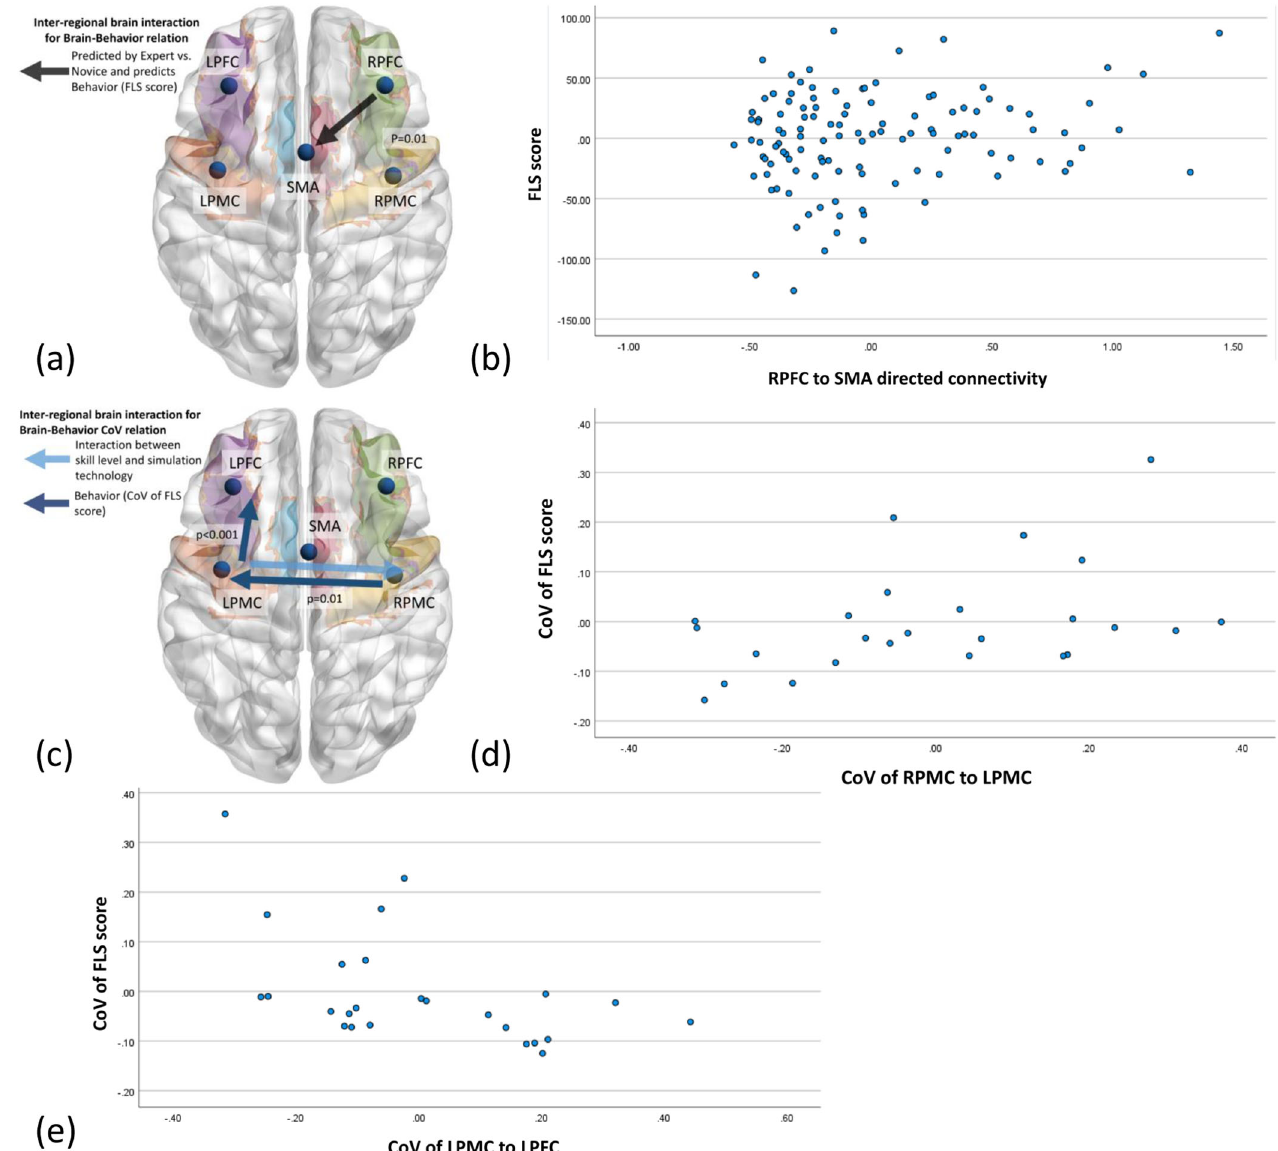
Fig. 4 Brain – behavior relationships for the FLS score and the coef fi cient of variation (CoV) of the FLS score. a Interregional directed functional brain connectivity from the RPFC to SMA as a signi fi cant ( p = 0.01) predictor of the FLS score where RPFC to SMA functional connectivity is signi fi cantly ( p < 0.05) affected by skill level (expert vs. novice). b The plot shows the partial regression of the interregional directed functional brain connectivity of the RPFC to SMA as a predictor of the FLS score. c CoV of the interregional directed functional brain connectivity from the RPMC to LPMC ( p = 0.01) and LPMC to LPFC ( p < 0.001) as signi fi cant predictors for the CoV of the FLS score. The CoV of the LPMC to RPMC functional connectivity was signi fi cantly ( p < 0.05) affected by the interaction between the skill level and the simulation technology. d The plot shows the partial regression of the CoV of interregional directed functional brain connectivity from the RPMC to LPMC as a predictor of the CoV of the FLS score. e The plot shows the partial regression of the CoV of the interregional directed functional brain connectivity from the LPMC to LPFC as a predictor of the CoV of the FLS